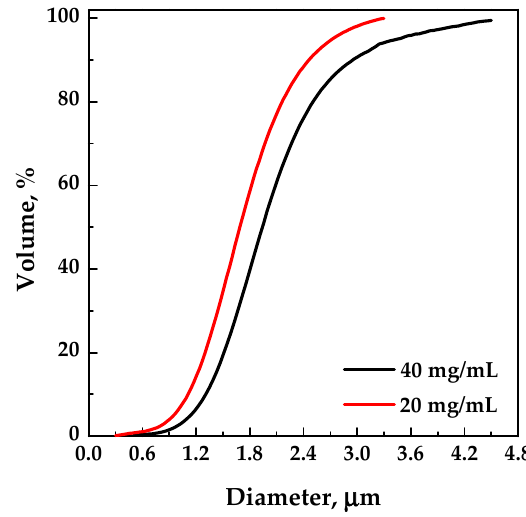
Figure 3. Volumetric cumulative particle size distributions (PSDs) of EUD precipitated from DMSO at 40 °C and 10 MPa; effect of the polymer concentration in DMSO.